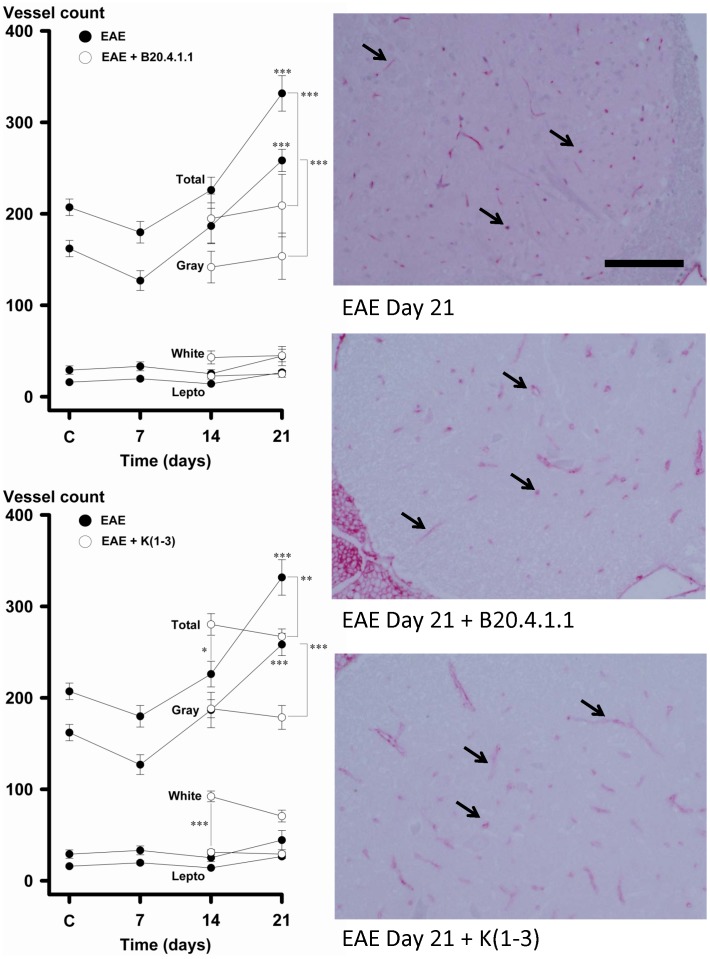
B20-4.1.1 and K(1-3) Inhibit Spinal Cord Angiogenesis During EAE.Left sided panels show vessel counts as a function of disease duration. Filled circles indicate data for untreated EAE, open circles for EAE treated with B20-4.1.1 (upper left) or K(1-3) (lower left). Data are shown as mean ± SEM obtained from per mouse values from 6-8 mice. Significance is relative to control or between points linked by cross bars (*, ***; P<0.05, 0.001). Right sided images show CD31 positive vessels in spinal cord for indicated groups. Arrows point to examples of individual blood vessels. Scale bar = 50 µm.